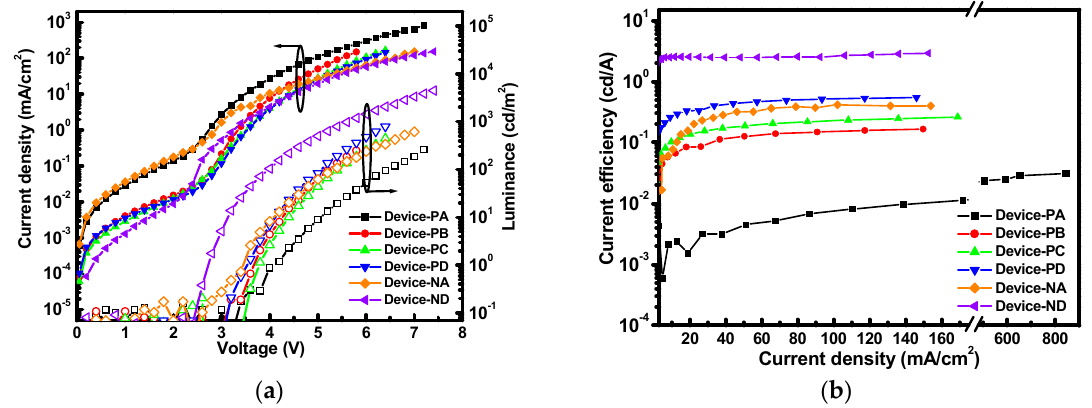
Figure 5. ( a ) L–J–V and ( b ) current efficiency-current density ( η CE - J ) characteristics of the PeLEDs.